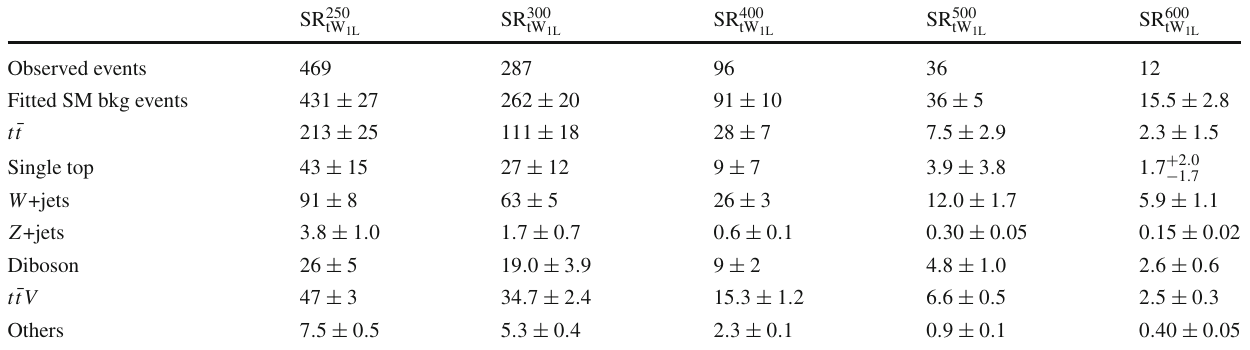
Table 8 Background-only fit results for tW 1L signal region bins for processes such as tW Z , triboson, t ¯ t t ¯ t , t ¯ t WW and Higgs boson pro- model-independent limits. Events with E miss above the lowest bin- duction processes) are grouped and labelled as ‘Others’. The quoted T threshold are retained in each bin. This is indicated by value X in uncertainties of the fitted SM background include both the statistical SR X . The backgrounds which contribute only a small amount (rare tW 1L